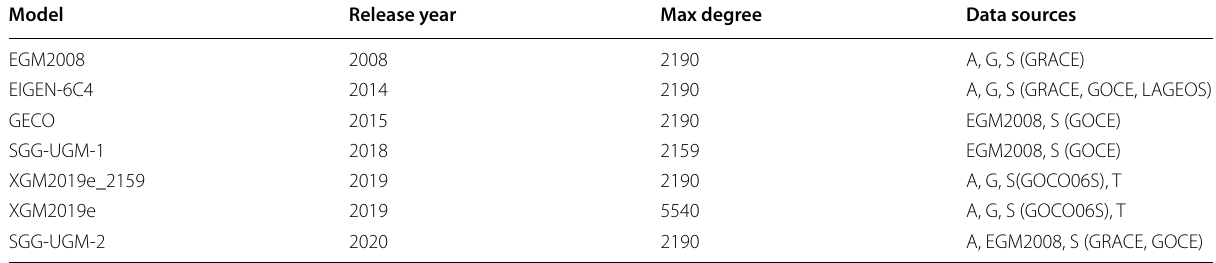
A is for altimetry, S is for satellite, G is for ground data and T is for topography